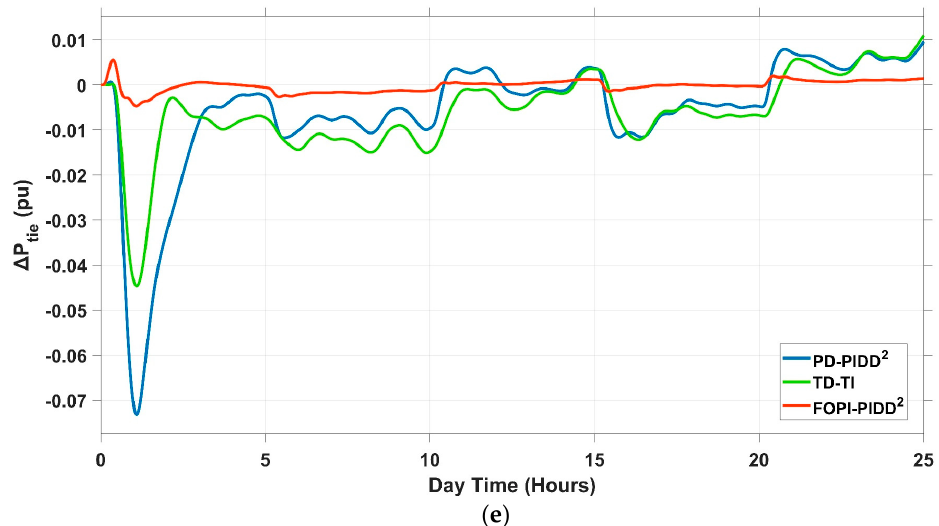
Figure 28. Comparison of PD–PIDD 2 , TD-–TI, and FOPI–PIDD 2 optimized by DO algorithm for